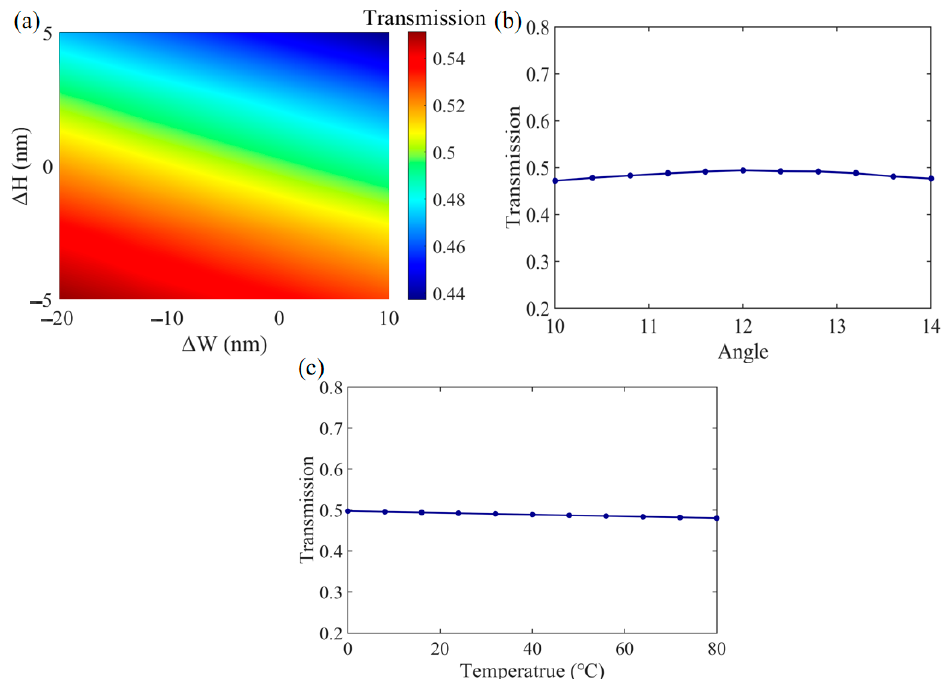
Figure 7. ( a ) Simulated fabrication tolerance to the deviation of waveguide width and thickness. ( b ) Simulated transmission curve from bar port at wavelength of 1300 nm with angle varying from 10 to 14 degrees. ( c ) The simulated temperature sensitivity of the proposed power spli tt er from 0 to 80 degrees at the wavelength of 1300 nm.